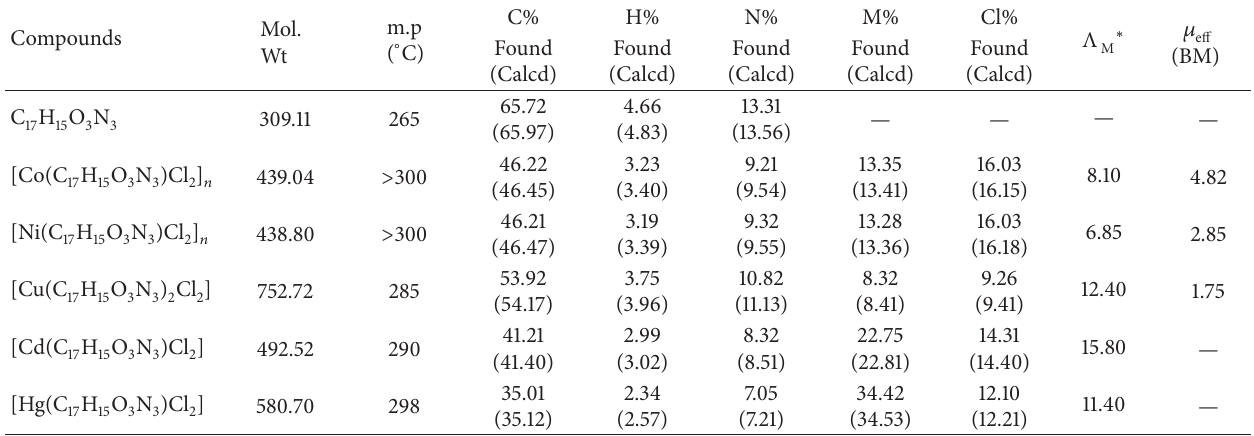
Table 1: Physical and analytical data of Schiff base and its